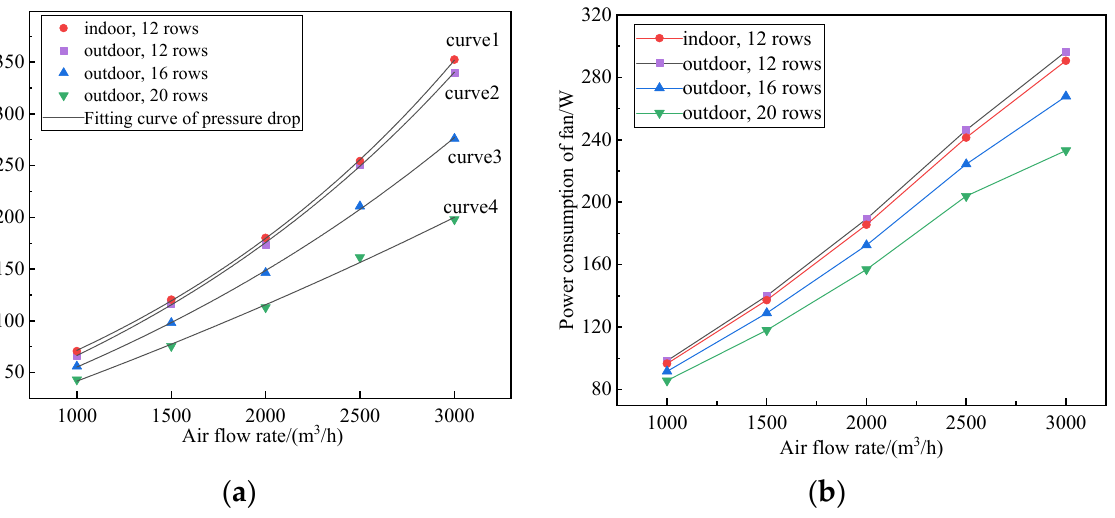
Figure 13. Flow characteristics under different q V , a : ( a ) pressure drop; ( b ) power consumption of fans. Table 6. Fitting curves of indoor and outdoor MHPA–AWHEs at different N . Curve Condition Fitting Curve of Pressure Drop R